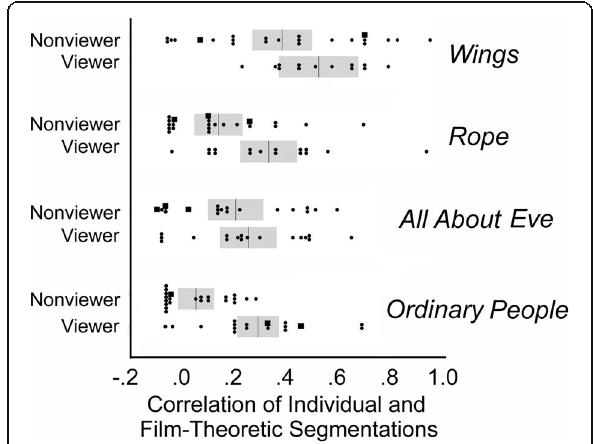
Fig. 5 A comparison of the individual subjects ’ data ( dots and squares ) expressed as correlations of their segmentations against film-theoretic segmentations. Viewers are the students in Experiment 1 who watched the movies and segmented them on written scenarios; non-viewers were the online workers of Experiment 2 who did not see the films but who read and responded only to the scenarios. The 11 non-viewers indicated by small squares claimed to have seen their film before. Faint , gray vertical lines indicate means and gray bands indicate standard errors of the